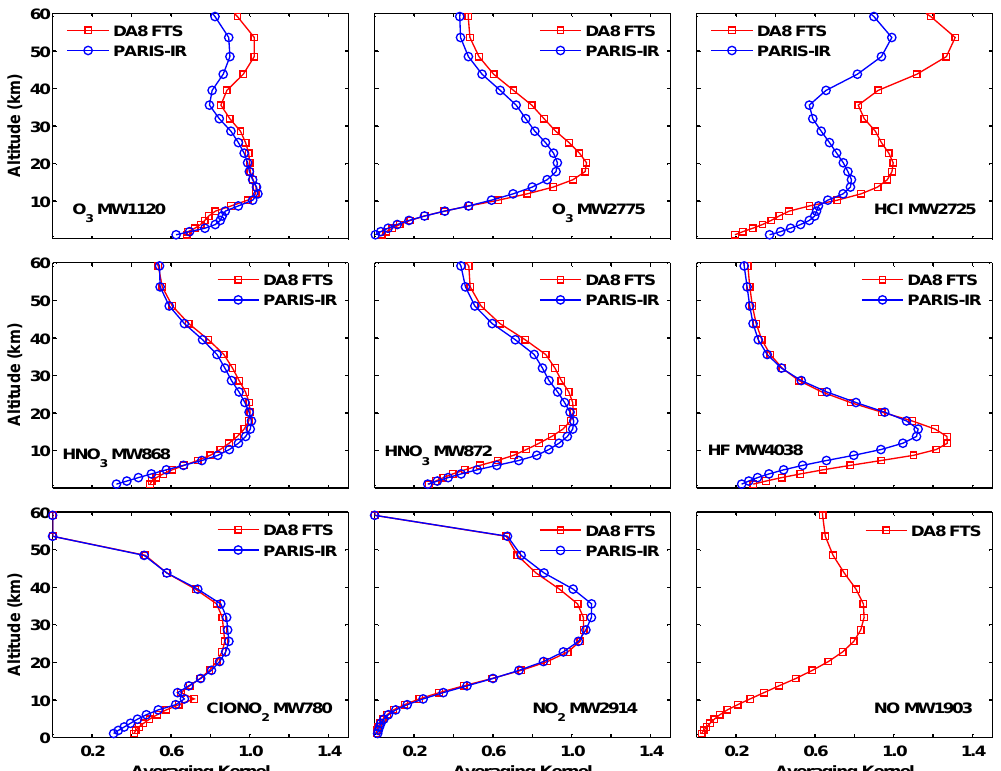
Fig. 1. Total column averaging kernels for PARIS-IR (blue circles) and the DA8 FTS (red squares) for 2006 Canadian Arctic ACE Validation